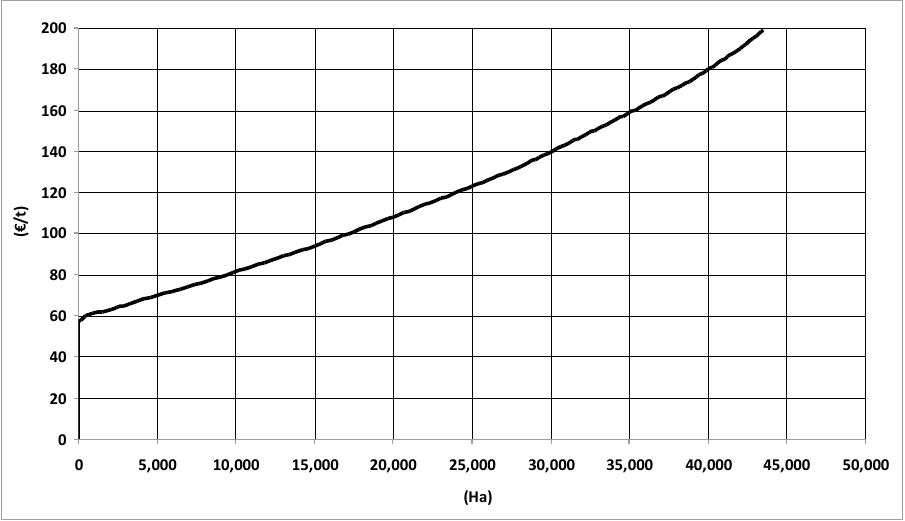
Figure 3. Evolution of the sorghum hectares due to price variation (Parma province).